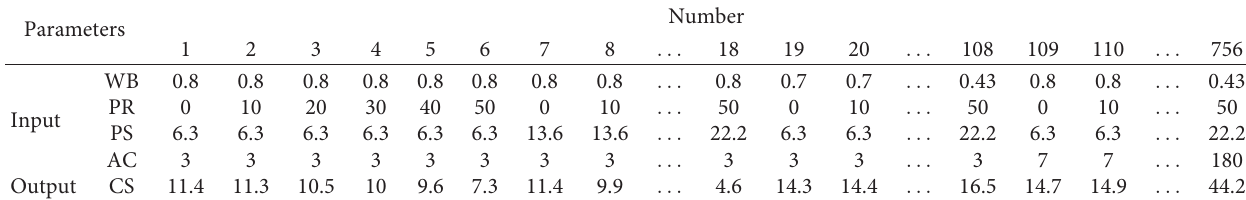
Table 6: The parameter format used in the ANN